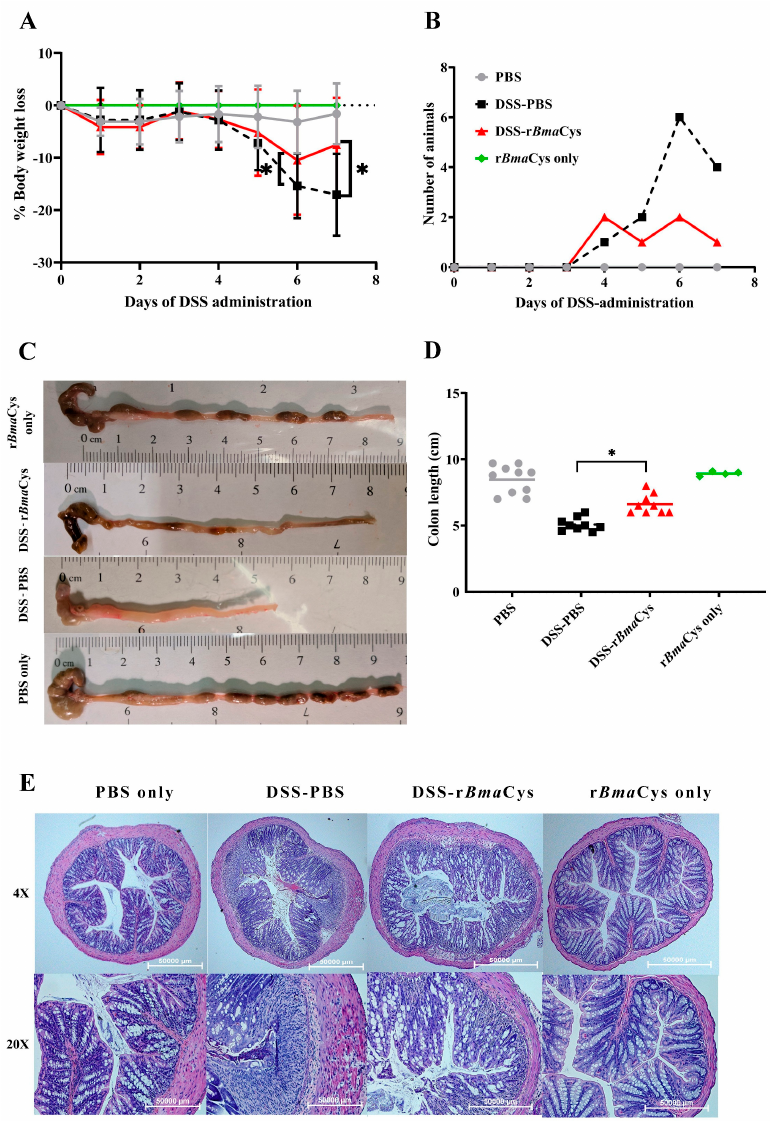
Figure 1. r Bma Cys-treatment ameliorated dextran sulfate sodium (DSS)-induced damage to the colon. Clinical signs of colitis were monitored in all the animals throughout the experimental period (day 1–7 after DSS-administration). ( A ) Loss of body weight is expressed as percentages (mean ± S.D. values). DSS-r Bma Cys-treated mice showed a reduced loss in their body weights compared to the DSS only group. ( B ) In the DSS-PBS group, several animals showed blood in the feces. However, by day 7, only one animal in the DSS-r Bma Cys treated group had blood in the feces compared to four animals in the DSS-PBS group. Thus, the clinical symptoms of colitis were substantially reduced following r Bma Cys-treatment. ( C ) Representative figures of colons from all the experimental groups. ( D ) The graph represents individual and means colon lengths (mean ± S.D. values) for each group of animals. r Bma Cys-treatment significantly reduced the damaging e ff ects of DSS on the colon length. ( E ) H&E stained tissue sections of colon samples. Compared to the DSS-PBS group, colon tissue from DSS-r Bma Cys-treated mice had substantial preservation of normal colon histology and decreased cellular infiltration. * P ≤ 0.05 compared to DSS-PBS group as determined using one-way ANOVA followed by Tukey’s posthoc test, n = 10 mice per group, except the r Bma Cys only group, which had 4